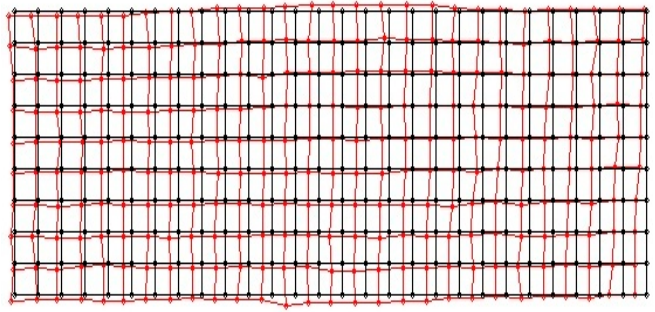
Figure 9. First experimental results of position errors between the real and the visually detected center position of the object.